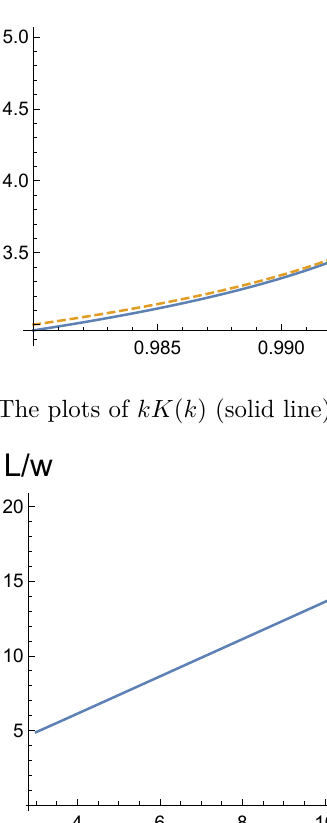
Figure 3 . The ratio of the size of the extra dimension L to the domain-wall width w as a function (cid:8) (cid:9) of s = ln 1 / (1 − k 2 ) in the case of n = 2